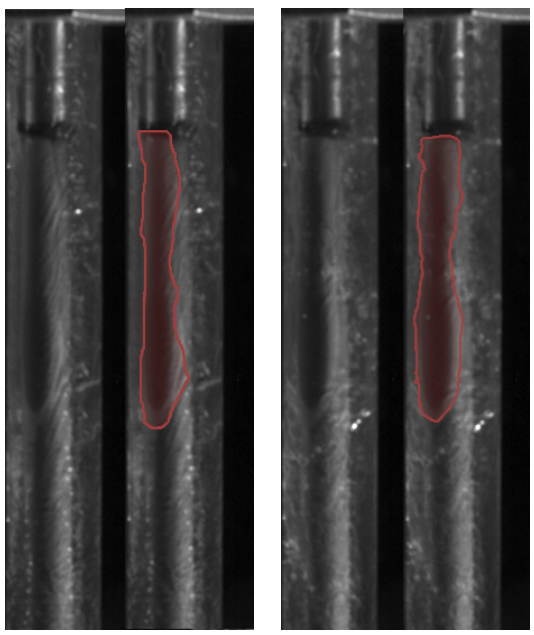
Figure 11. Glowing during CHF Figure 12. Post CHF overheated surface